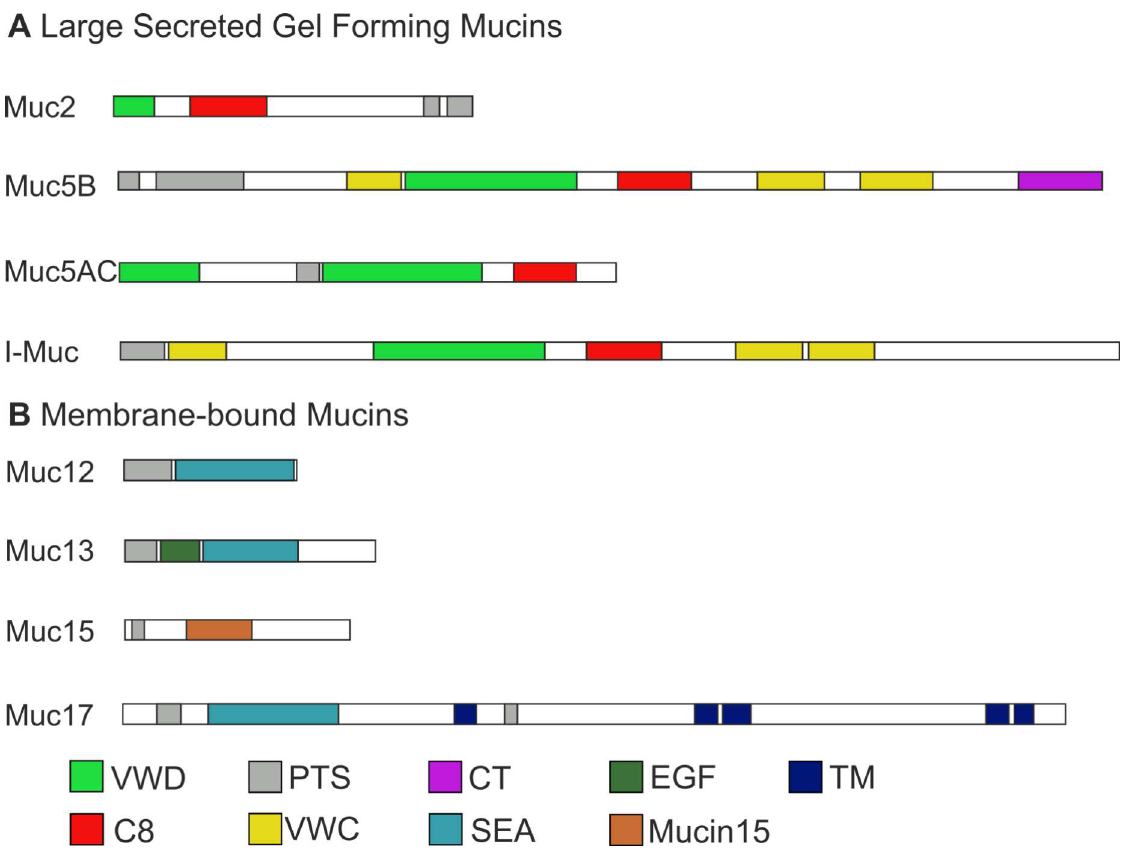
Fig 3. Schematic representation of the molecular structure of the eight sea trout skin mucins. Based on ST_51843, ST_271, ST_5641,ST_39, ST_35504,ST_27547,ST_7108,and